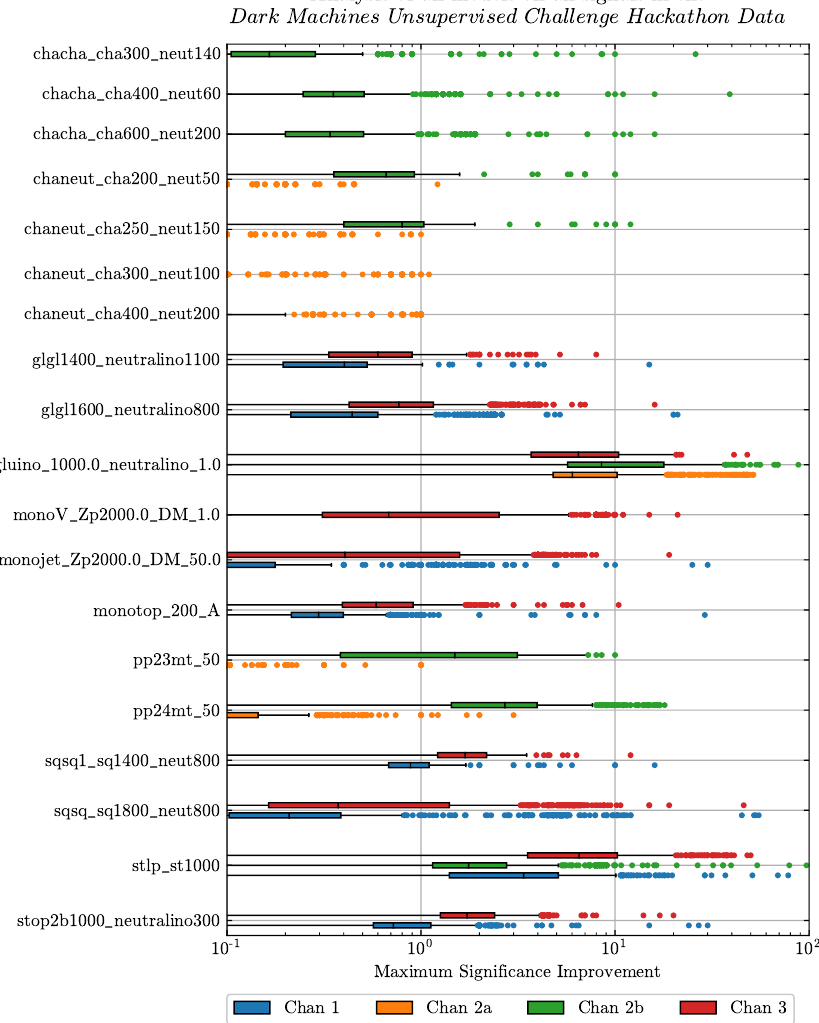
Figure 18: Box plots for each of the physics signals in the hackathon dataset. These summarize the span of results for the many anomaly detection models trained on background only samples. The SI is defined as ε improvement over the three working points ( ε the metric for each